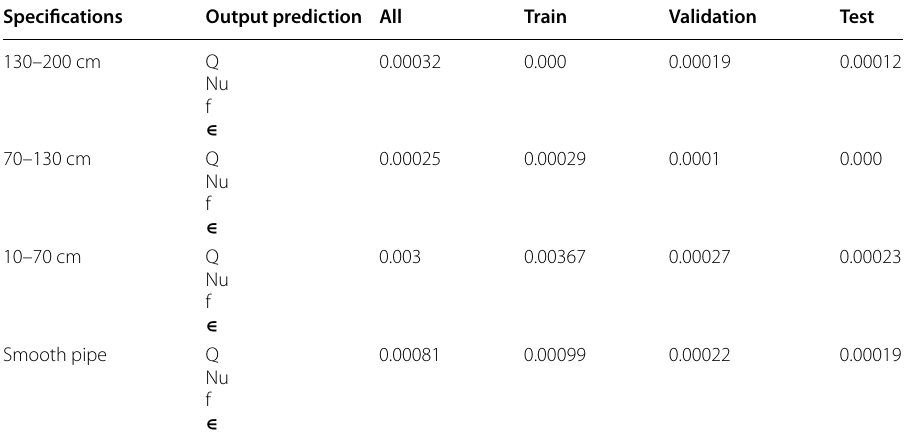
Table 1 Performance of ANN prediction with and without bumpers